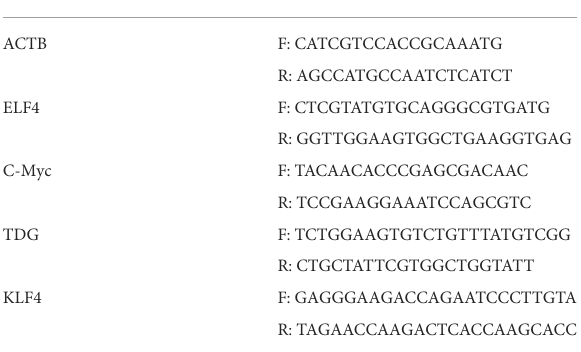
TABLE 3 Antibodies used for Immunofluorescence staining and Western blotting.